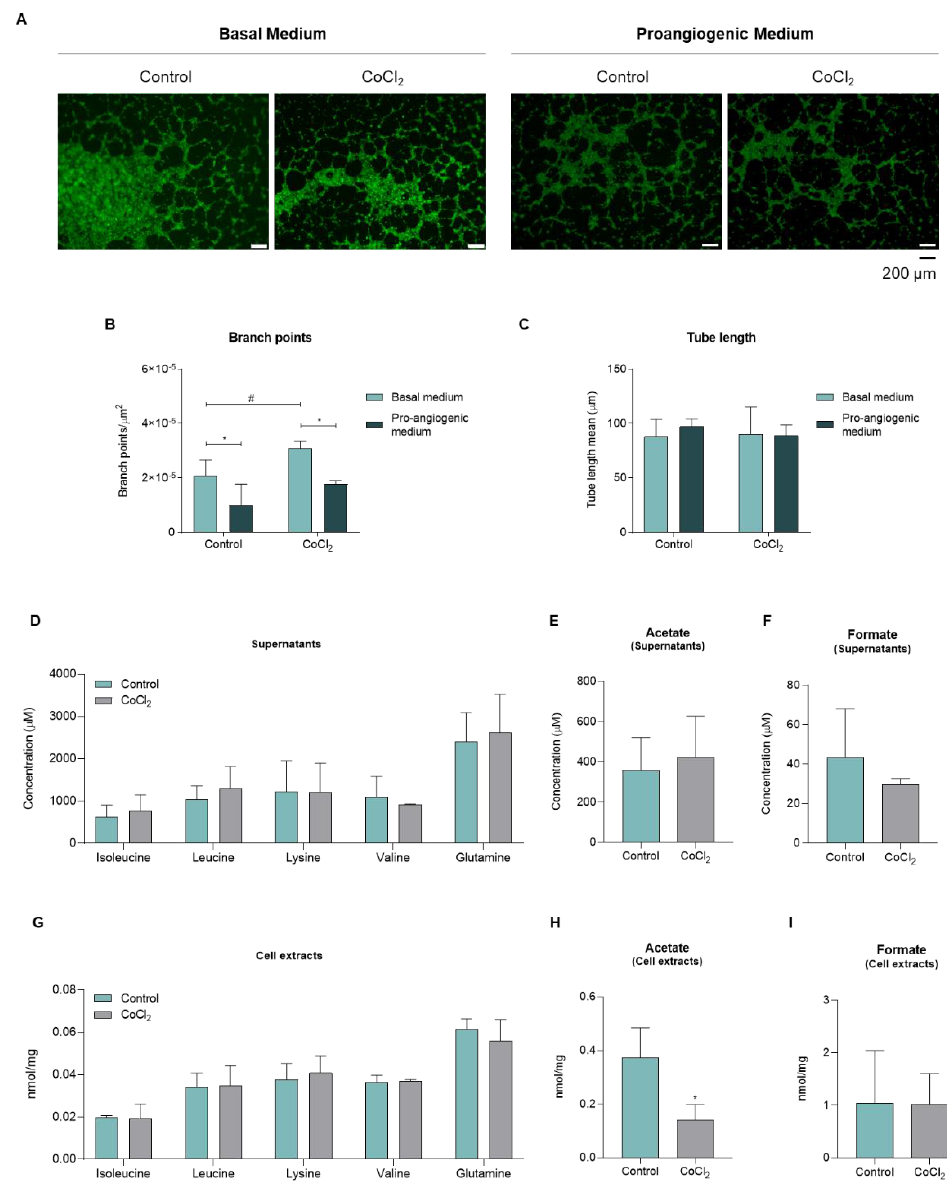
Figure 3. Hypoxia potentiates the formation of vessel-like structures and decreases the extracel- lular acetate levels. Human umbilical vein endothelial cells (HUVECs) were cultured in basal cul- ture condition (control) and in hypoxia-mimicked condition ( 200 μM CoCl 2 ). A tube forming assay was performed in Matrigel upon these culture conditions for 6 h. ( A ) Representative images (40×, scale: 200 μm) of vessel -like structures formed by calcein-labeled HUVECs. Cells were exposed to CoCl 2 -mimicked hypoxia and cultured in basal or proangiogenic medium. Quantification of the re- spective branch points ( B ) and tube length ( C ) of the newly formed vessel-like structures. HUVECs cultured in the same conditions were collected, and cell extracts were performed, and cell culture media (supernatants) were collected for nuclear magnetic resonance (NMR) spectroscopy analysis. ( D ) Concentration of amino acids detected in the supernatant of HUVECs treated with CoCl 2 . ( E ) Acetate levels in HUVECs’ supernatant. ( F ) Formate levels in HUVECs’ supernatant. ( G ) Concen- tration of amino acids detected in cellular extracts of HUVECs treated with CoCl 2 . ( H ) Acetate levels in HUVECs’ cellular extracts. ( I ) Formate leve ls in HUVECs’ cellular extracts. All data are repre- sented as mean ± SD. (*) p < 0.05, two-way ANOVA; (#) p < 0.05, unpaired t- test. 3.3. Cysteine Does Not Affect the Sprouting of Aortic Rings and Tends to Shift the Metabolic Profile